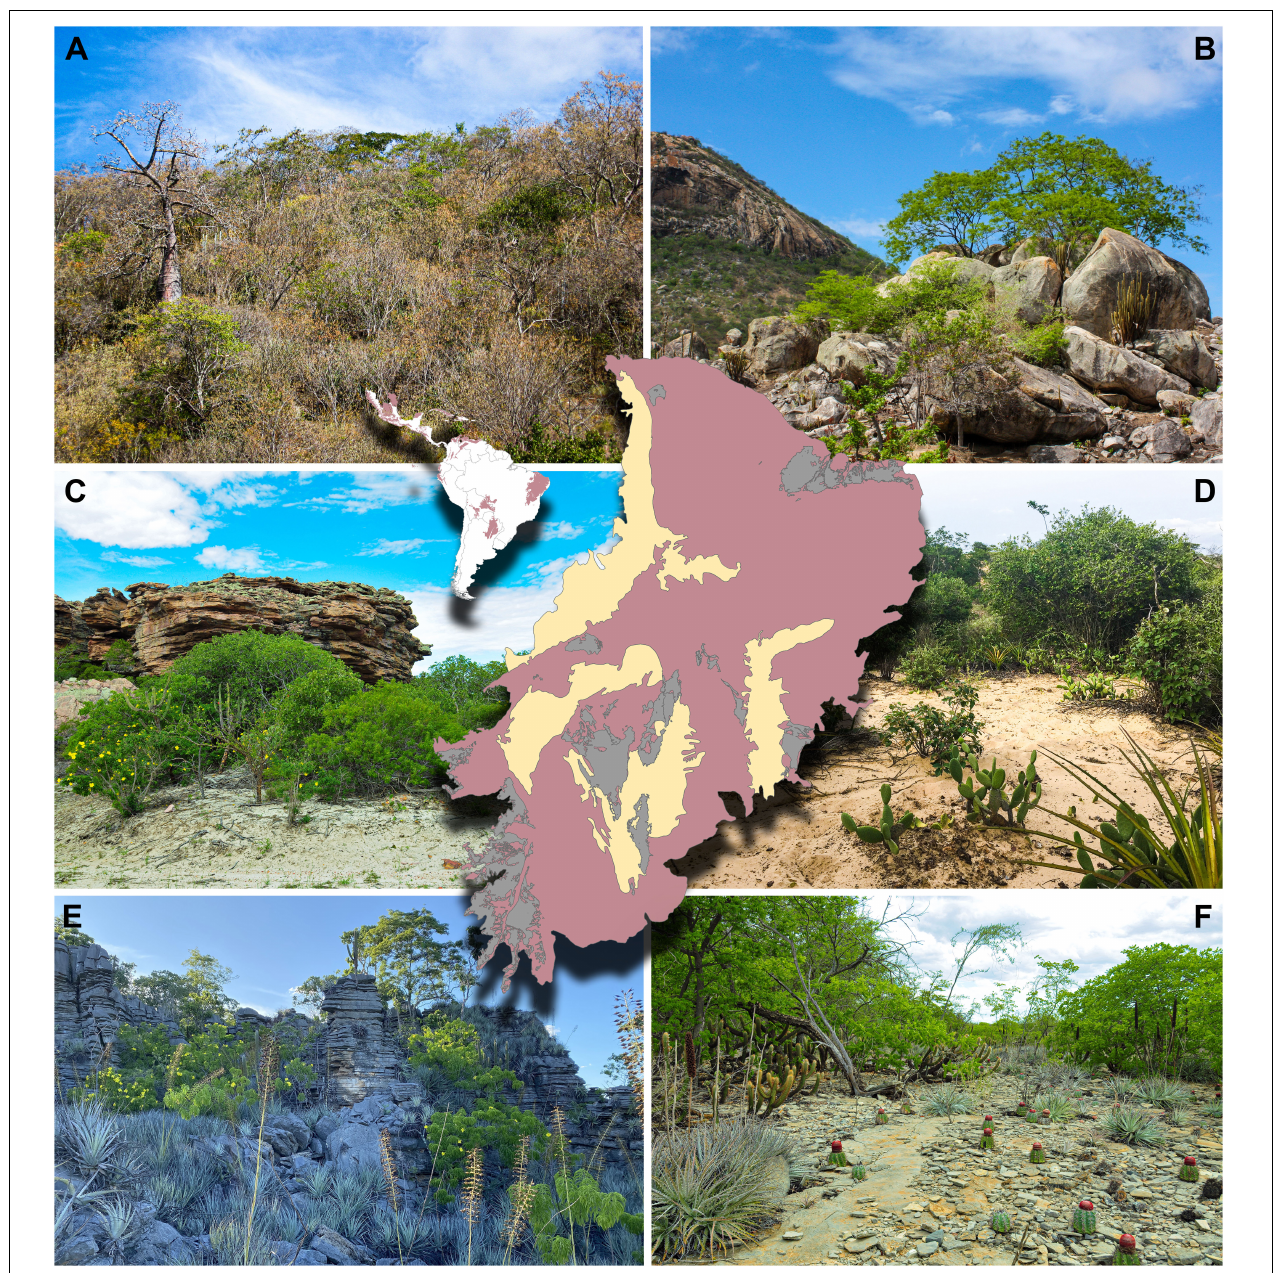
FIGURE 1 | Vegetation structure variation throughout the three main geological types of the Caatinga seasonally dry forests. The small side map shows the distribution of the Caatinga in Northeast Brazil in the context of the Seasonally Dry Tropical Forest biome (SDTF) in the Neotropics (Queiroz et al., 2017). The Depressão Sertaneja (red; A,B ) is the most dominant and continuously distributed formation, while the Sedimentary Caatinga (pale yellow; C,D ) and Karst Caatinga (gray; E,F ) are patchily distributed. Representative images highlight the structurally heterogenous vegetation, with exposed crystalline rocks, white-sand soil, or limestones, from across these main geological formations at: (A) Parnamirim, Bahia, showing the Arboreal Caatinga with a leafless large tree of the Brazilian baobab Cavanillesia umbellata (Malvaceae); (B) Sobral, Ceará, showing a more open Crystalline Caatinga woodland with an individual of the dominant legume tree Luetzelburgia auriculata and the Caatinga endemic Pilosocereus chrysostele (Cactaceae); (C) Morro do Chapéu, Bahia, showing a Sedimentary Caatinga with the yellow-flowered shrub Allamanda puberula ; (D) Barra, Bahia, showing a sand dune of the mid São Francisco River valley with the endemic opuntioid cactus Tacinga inamoena ; (E) Parque Nacional Carvernas do Peruaçu, Minas Gerais, showing the exposed razor-sharp limestone outcrops, dominated by individuals of the Bromeliaceae Encholirium luxor and the karst endemic Allamanda calcicola ; (F) Morro do Chapéu, Bahia, with individuals of the barrel Cactaceae Melocactus pachyacanthus , and the Caatinga endemic Encholirium spectabile and the columnar Cactaceae Xiquexique gounellei . All photos by Domingos Cardoso.